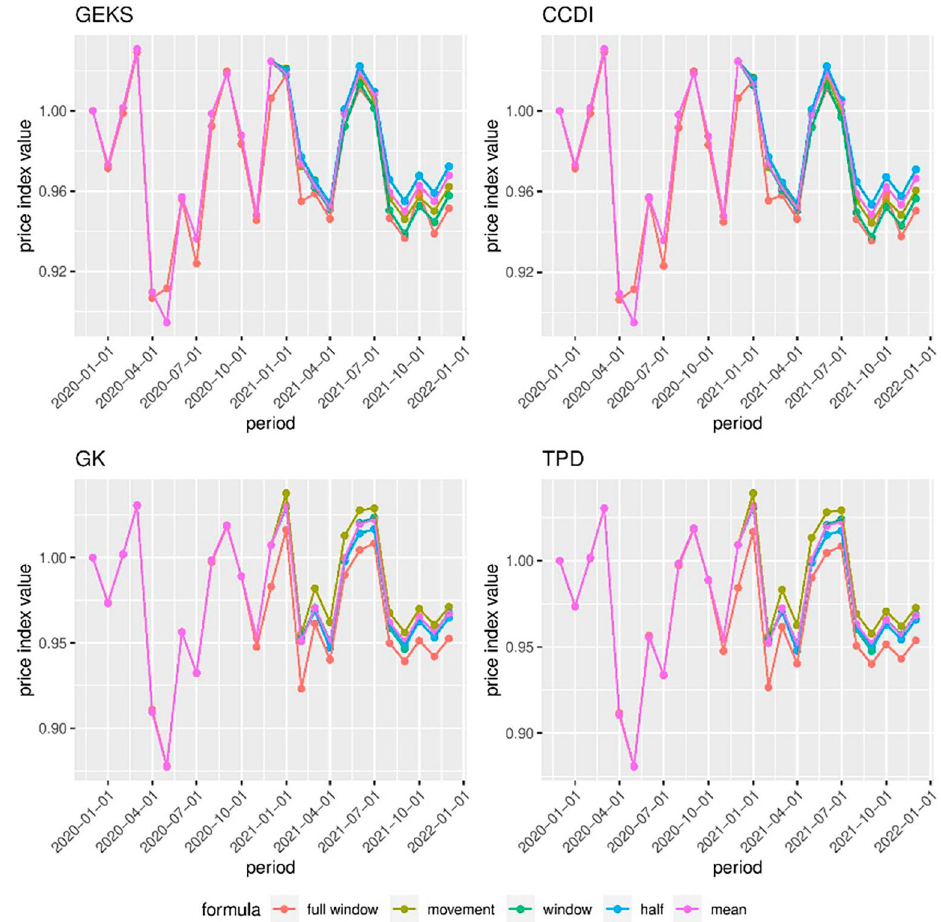
Figure A3. Comparison of c IDT G indices (splicing methods vs full time indices) for joghurt